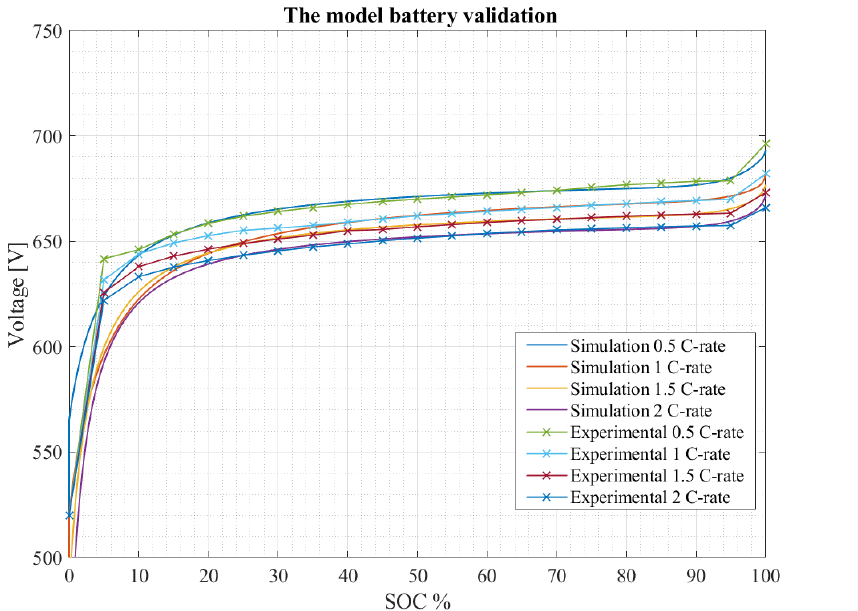
Figure 15. Comparison of the voltage–discharge curve values obtained from the model with the values carried out during the experimental tests on the